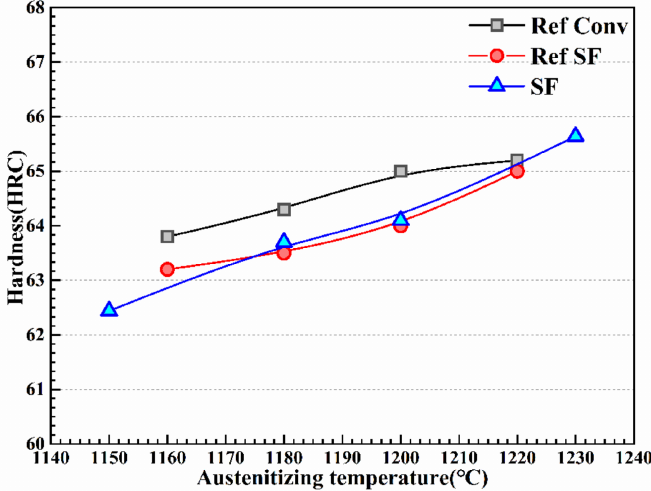
Figure 10. The tempering hardness curve at different quenching